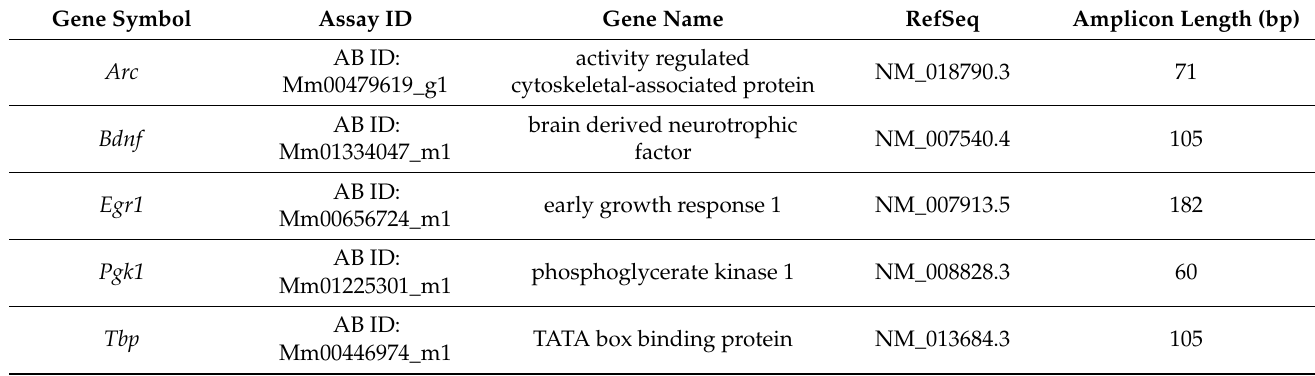
Table 1. The table shows the data on used primers: Gene symbols, assay IDs, gene names, GenBank reference sequence accession numbers and amplicon lengths